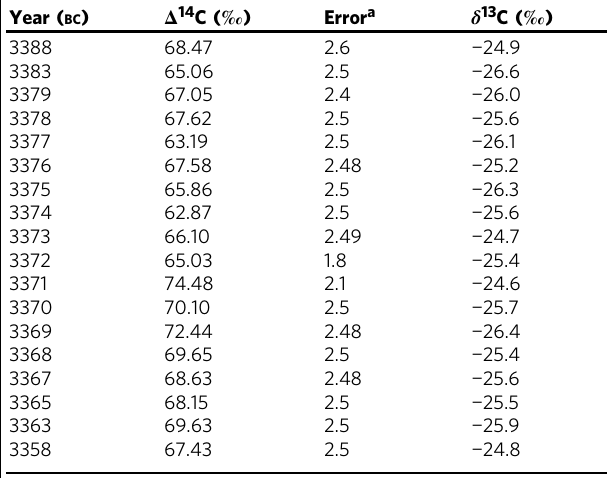
Table 1 Measured results in the Beta Analytic